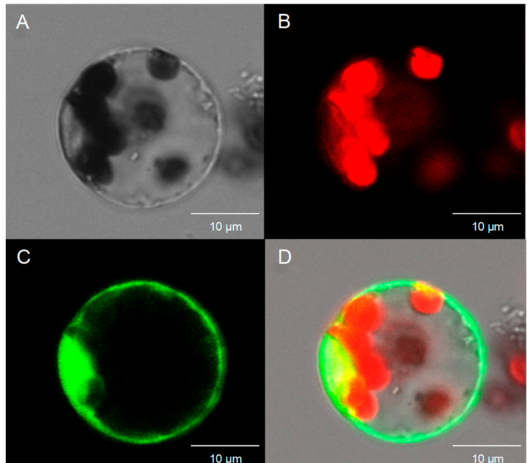
Figure 5. Subcellular localization of chrysanthemum CmSTM gene in chrysanthemum protoplast (( A ) shows the cells under bright field, ( B ) shows the spontaneous red light of chloroplasts, ( C ) shows the green fluorescence of GFP protein, and ( D ) shows the superposition of bright field and